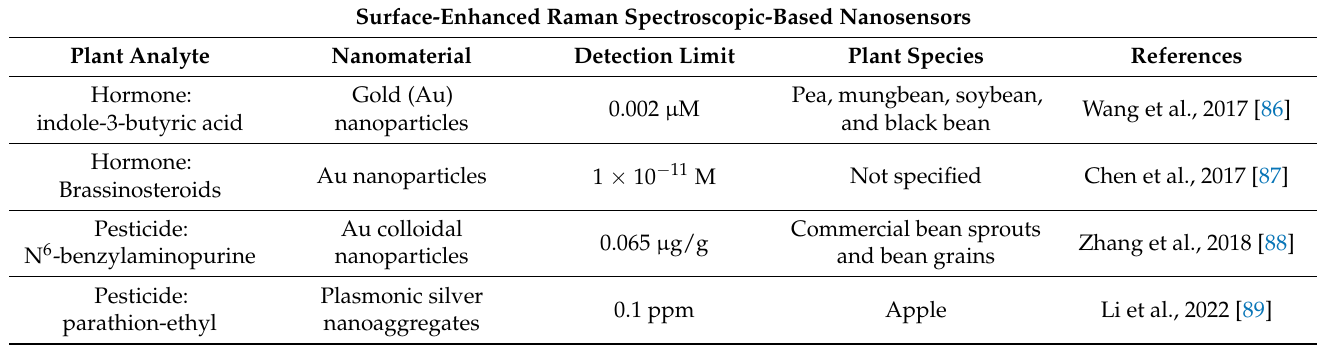
Table 3. Surface-enhanced Raman spectroscopic analysis of plant